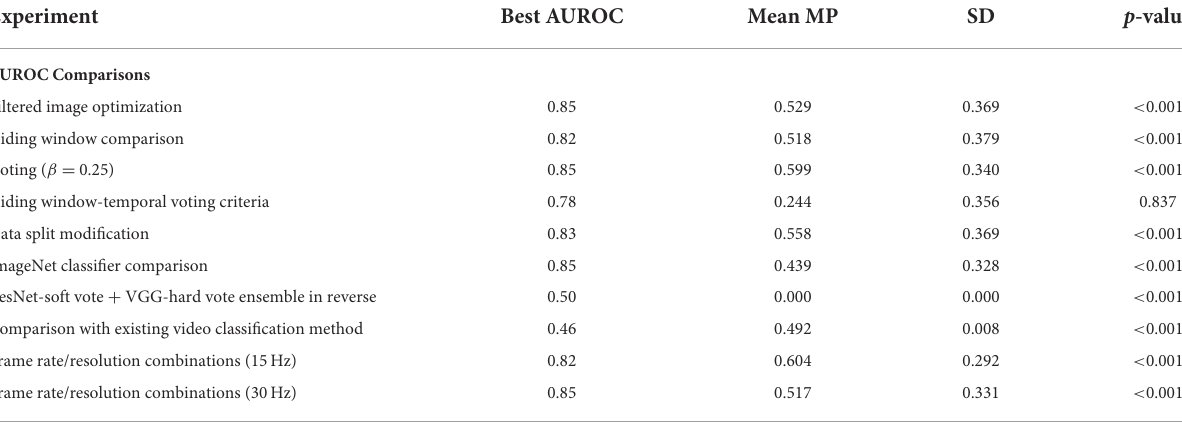
TABLE 2 Comparing best overall AUROC (ResNet-soft vote + VGG-hard vote ensemble) with best AUROC from each model experiment shown in Table 1 using two sample (unpaired) t -test.